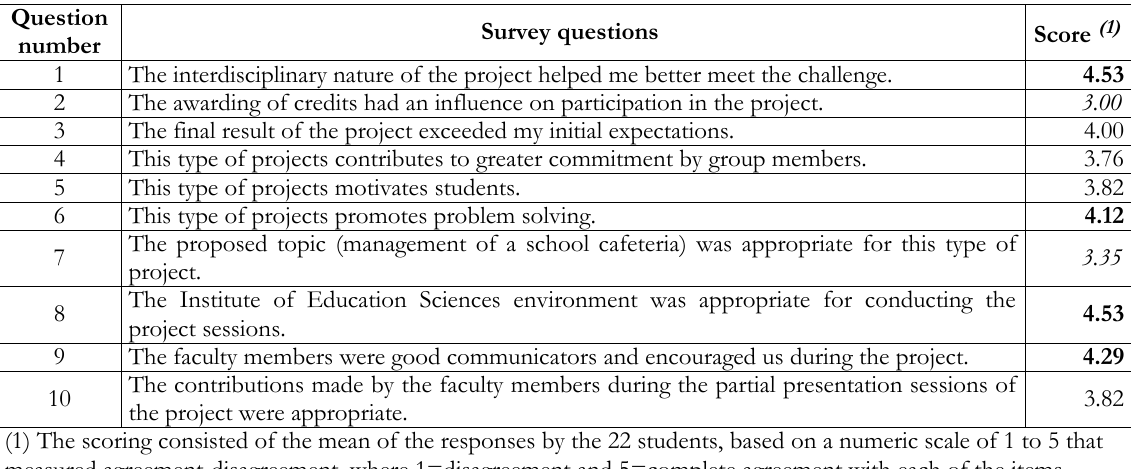
Table 3. Mean values obtained for the different items included on the survey administered to the students participating in the MESSI